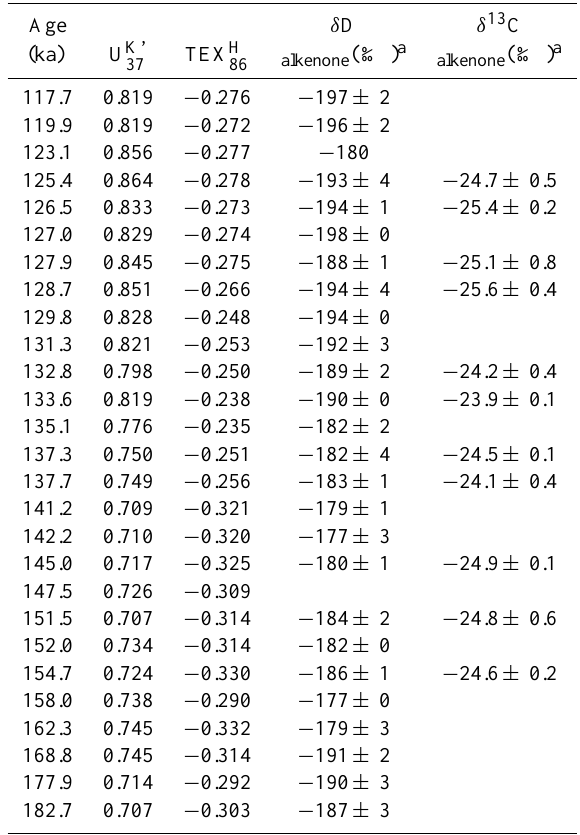
Table 1. Results for combined C 37 : 2 − 3 alkenone stable